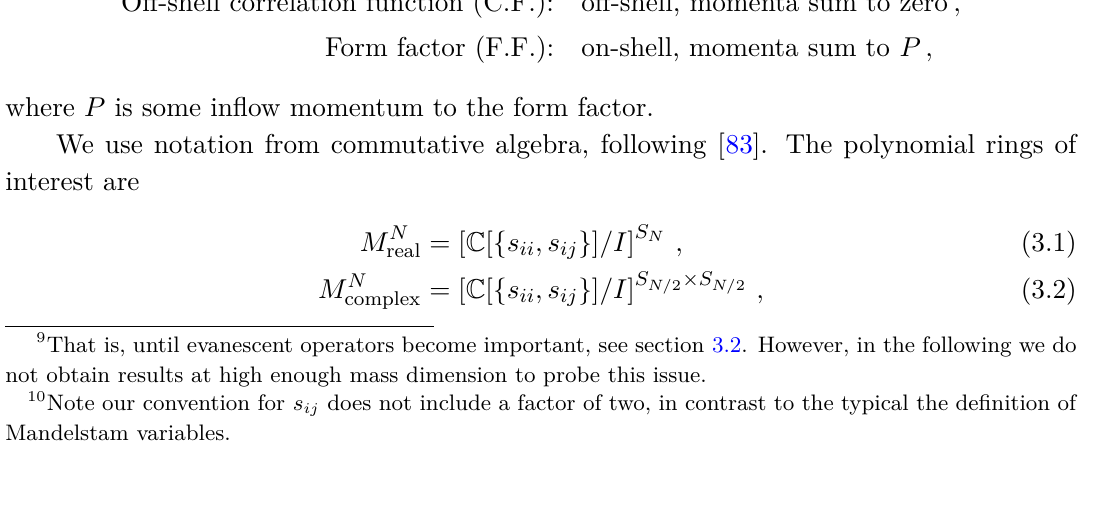
for: S -matrices, off-shell correlation functions, and form